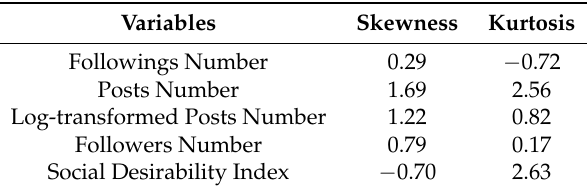
Table 3. Summary of skewness and kurtosis values for each Instagram variable. The log-transformed number of posts shows an enhancement of the power values compared to the same non-adjusted